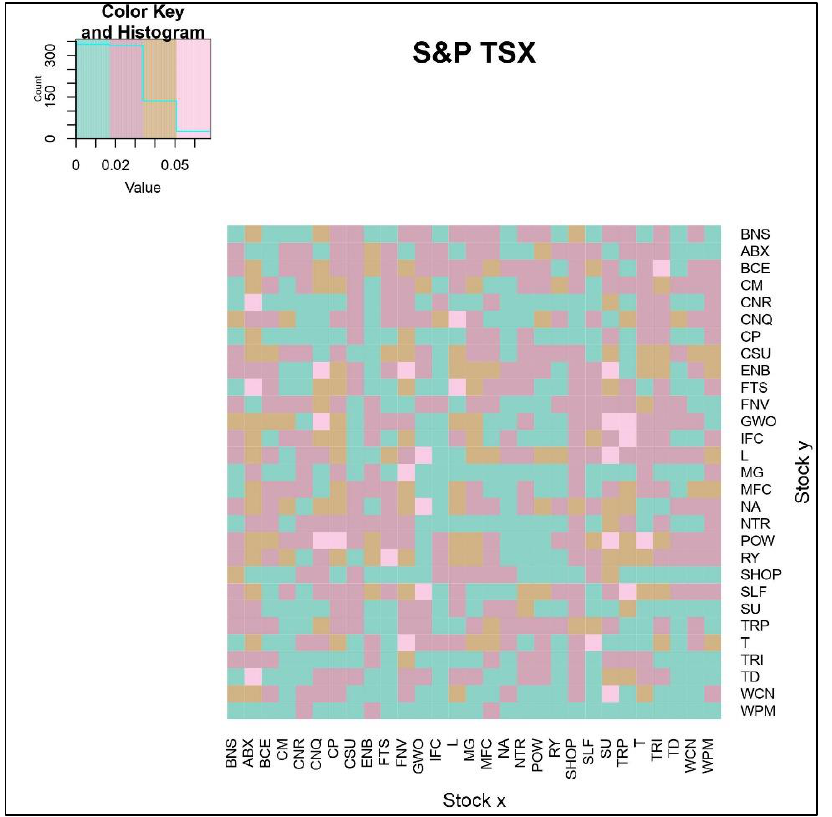
Figure 24. The information flow (effective transfer entropy) from stock y to stock x, for the top companies (by market capitalization) in the S&P SX market, after the COVID-19